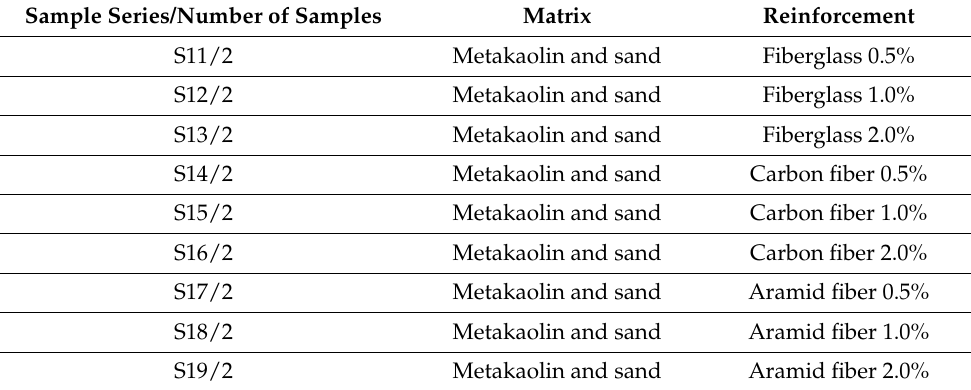
Table 2. Cont. Sample Series/Number of